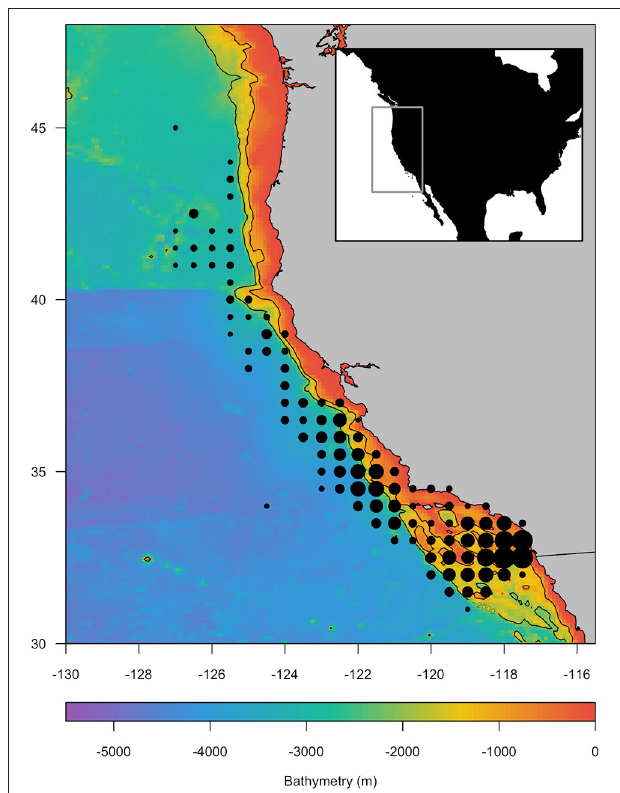
FIGURE 1 | Study area off the US West Coast indicating the bathymetry (m; color scale) and location of fishing sets during 1997–2017 (dots) within the Regional Ocean Modeling System (ROMS) domain (inset). Fishing sets locations are aggregated to the nearest 0.5 ◦ , and dot size indicates relative frequency of sets. The 1,000 and 2,000m bathymetric contours are